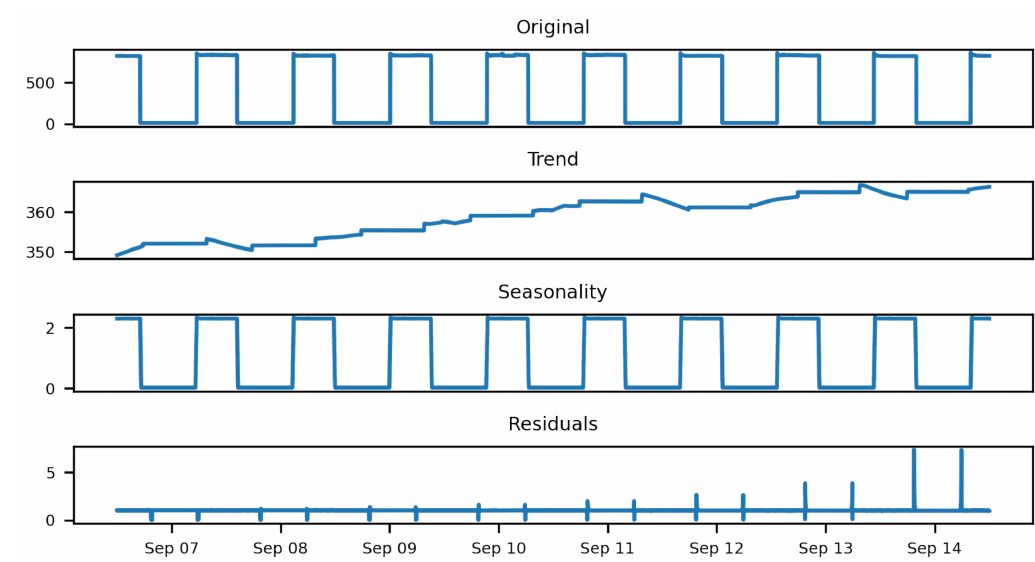
Figure 7. Decomposition of active power time series for the autumn